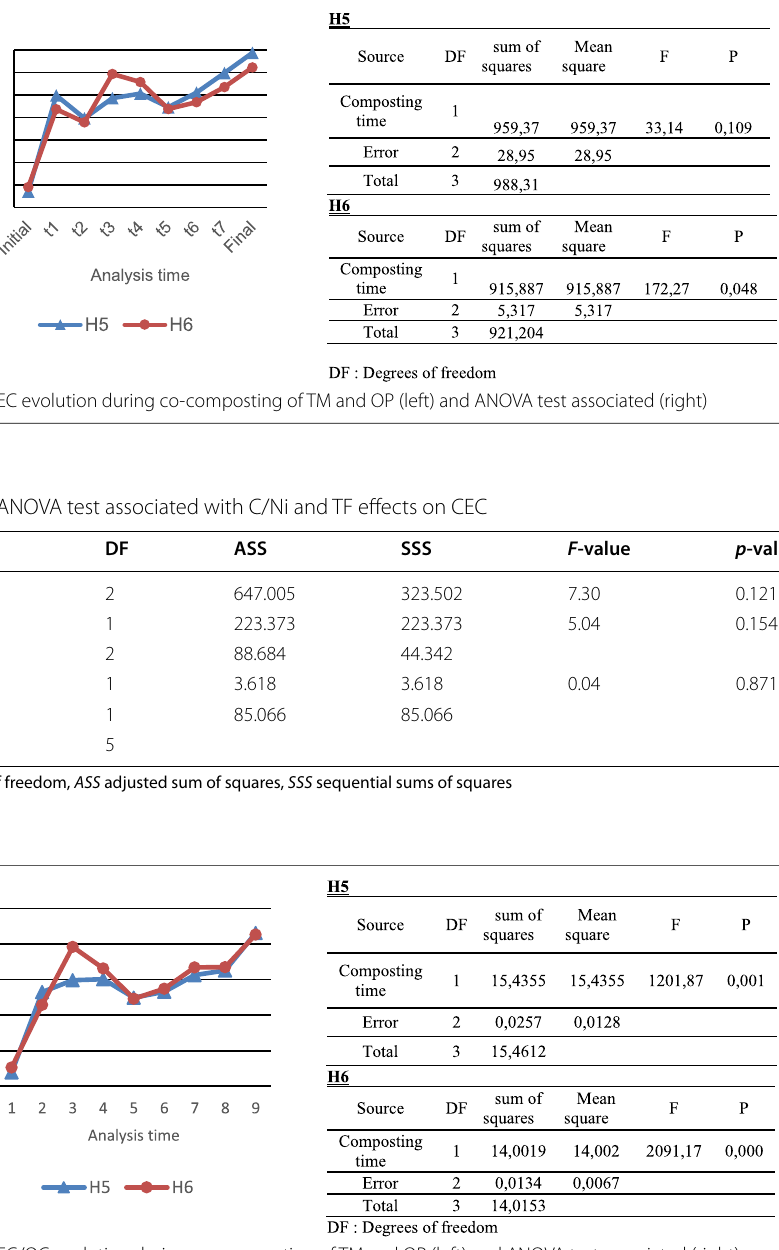
Fig. 12 CEC/OC evolution during co‑composting of TM and OP (left) and ANOVA test associated